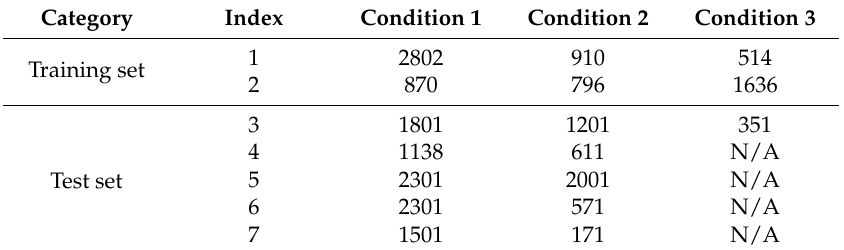
Table 1. Total numbers of observations in the IEEE PHM 2012 Challenge dataset.